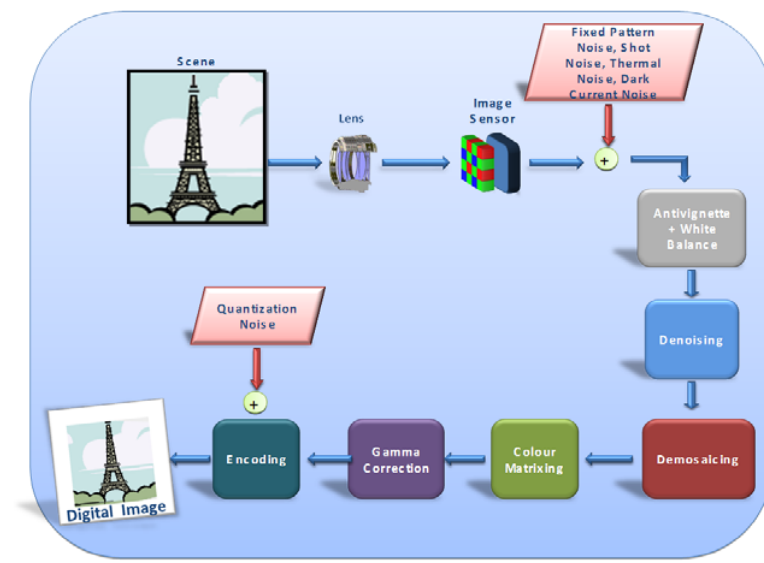
Figure 1 . Image Generation